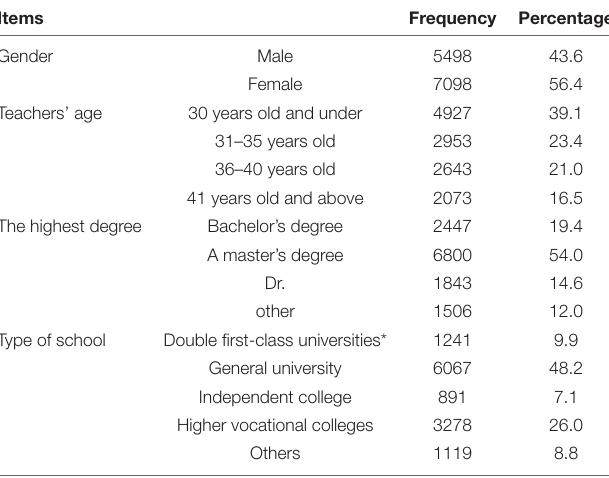
TABLE 1 | Basic information of sampling teachers ( N =